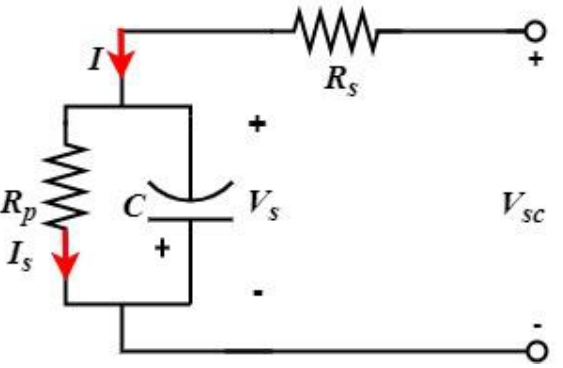
Figure 8. Used SC